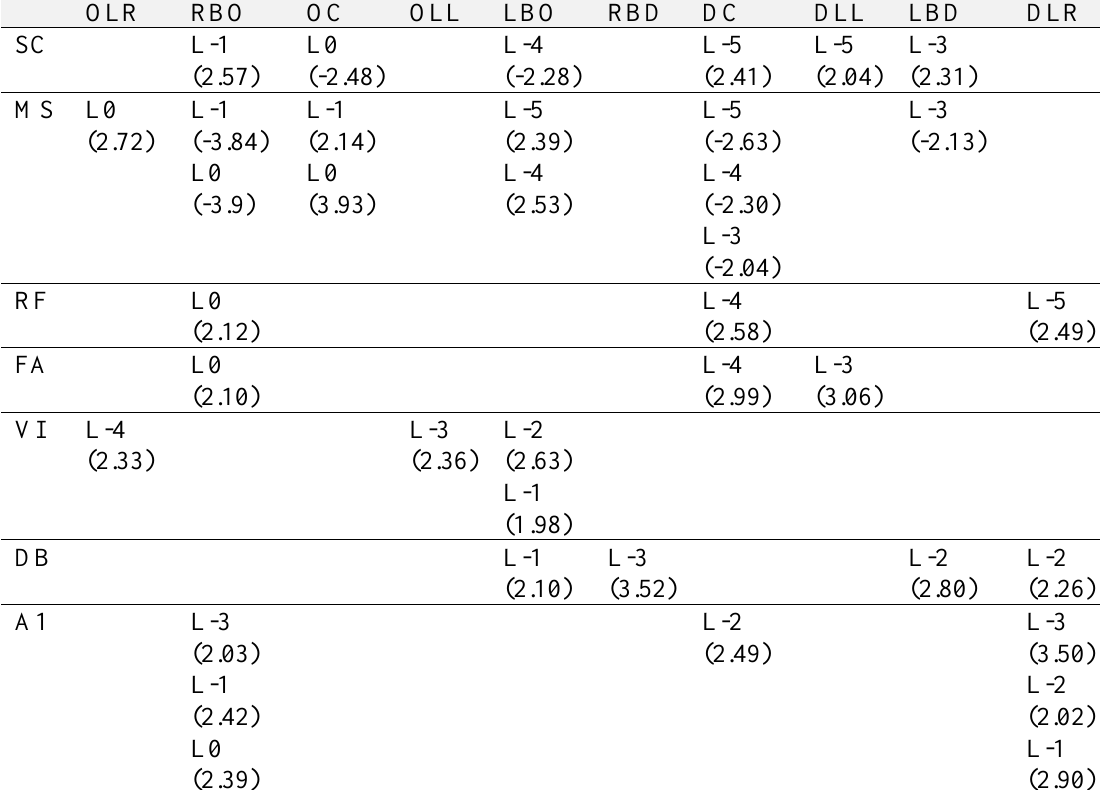
Score (SC); Mistake (MS); Received foul (RF); Foul in attack (FA); Violation (VI); Direct block (DB); Basket and Foul (A1). In the top row are the target behaviours: Offensive lateral right (OLR); Right bottom offensive (RBO); Offensive centre (OC); Offensive lateral left (OLL); Left bottom offensive (LBO); Right bottom defensive (RBD); Defensive centre (DC); Defensive lateral left (DLL); Left bottom defensive (LBD); Defensive lateral right (DLR). Negative adjusted residuals that imply inhibitory relationships between associated behaviours are